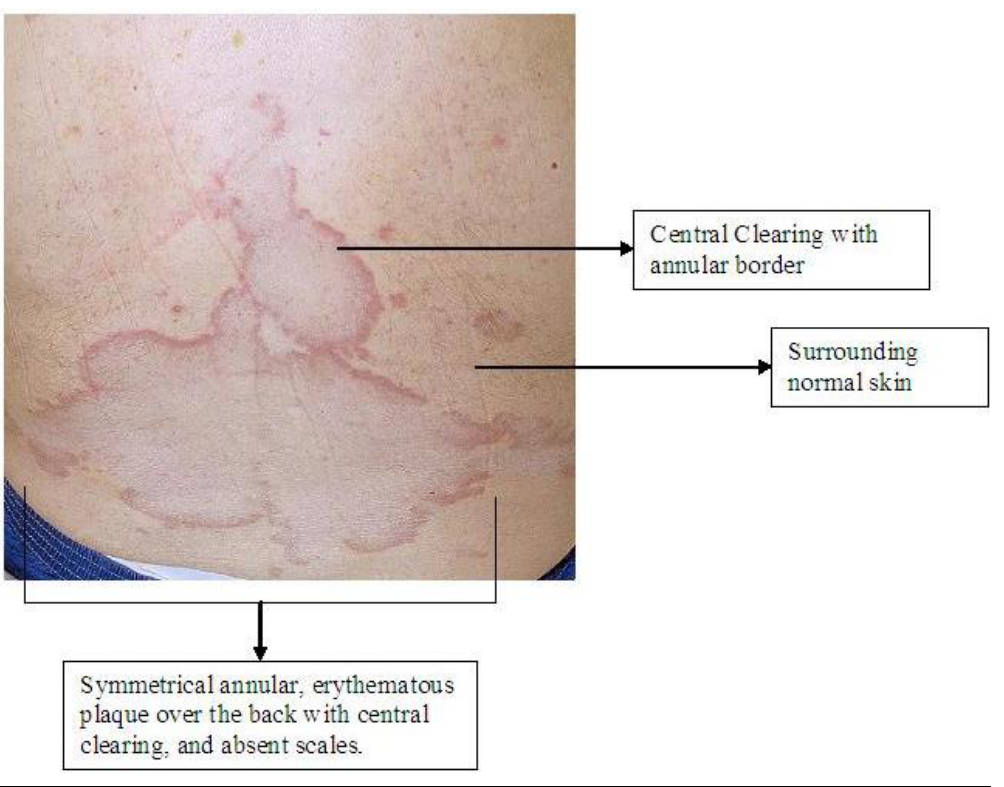
FIGURE 1. Back of the